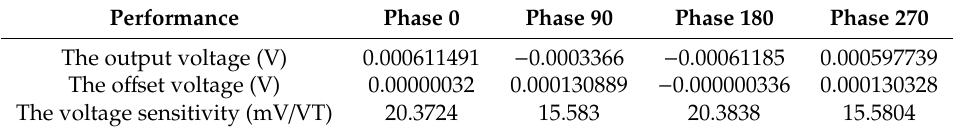
Table 1. The o ff set voltages and voltage sensitivity of the double three-contact structure.